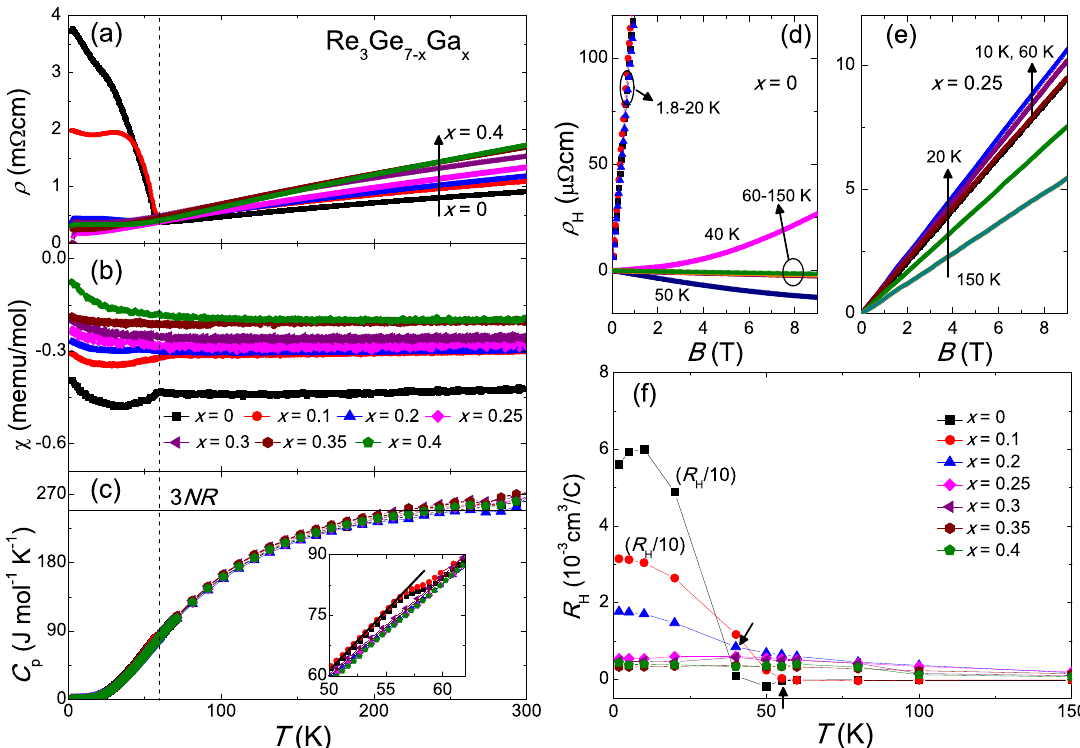
Fig. 3 Evolution of resistivity, magnetic susceptibility, speci fi c-heat, and Hall coef fi cient with Ga content in Re 3 Ge 7 − x Ga x . a – c Temperature dependence of resistivity, magnetic susceptibility, and speci fi c heat below 300 K for the series of Re 3 Ge 7 − x Ga x samples, respectively. The vertical dashed line is a guide to the eyes. In ( a ), the arrow marks the increasing of Ga content x . In ( c ), the horizontal line is the Dulong – Petit limit of 3 NR = 249.42 J mol − 1 K − 1 , and the inset shows a zoom of the data between 50 and 62 K. d , e Magnetic fi eld dependence of Hall resistivity at various temperatures for the samples with x = 0 and 0.2, respectively. The circles and arrows are a guide to the eyes. f Temperature dependence of Hall coef fi cient for the series of samples. The anomalies are marked by the arrows, and the data for both x = 0 and 0.1 are divided by a factor of 10 for better